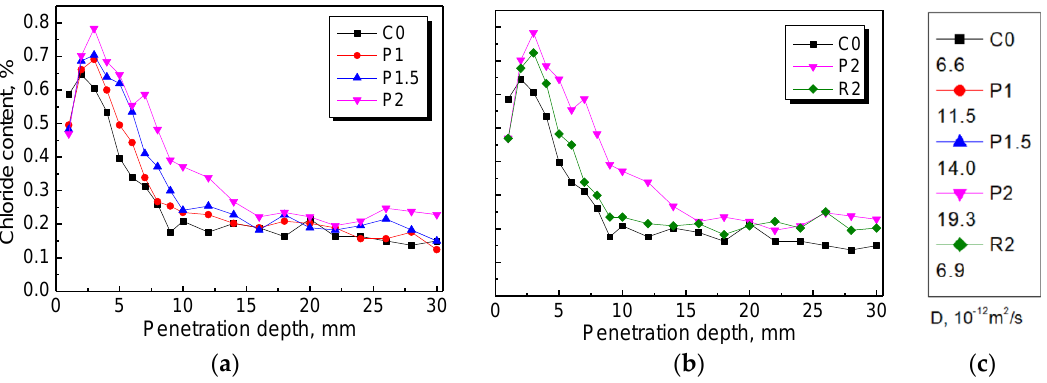
Figure 15. The influence of fiber content ( a ) and fiber type ( b ) on the resistance to chloride erosion of NPFRCCs. The coefficient of chloride diffusion (D) ( c ) of NPFRCCs.